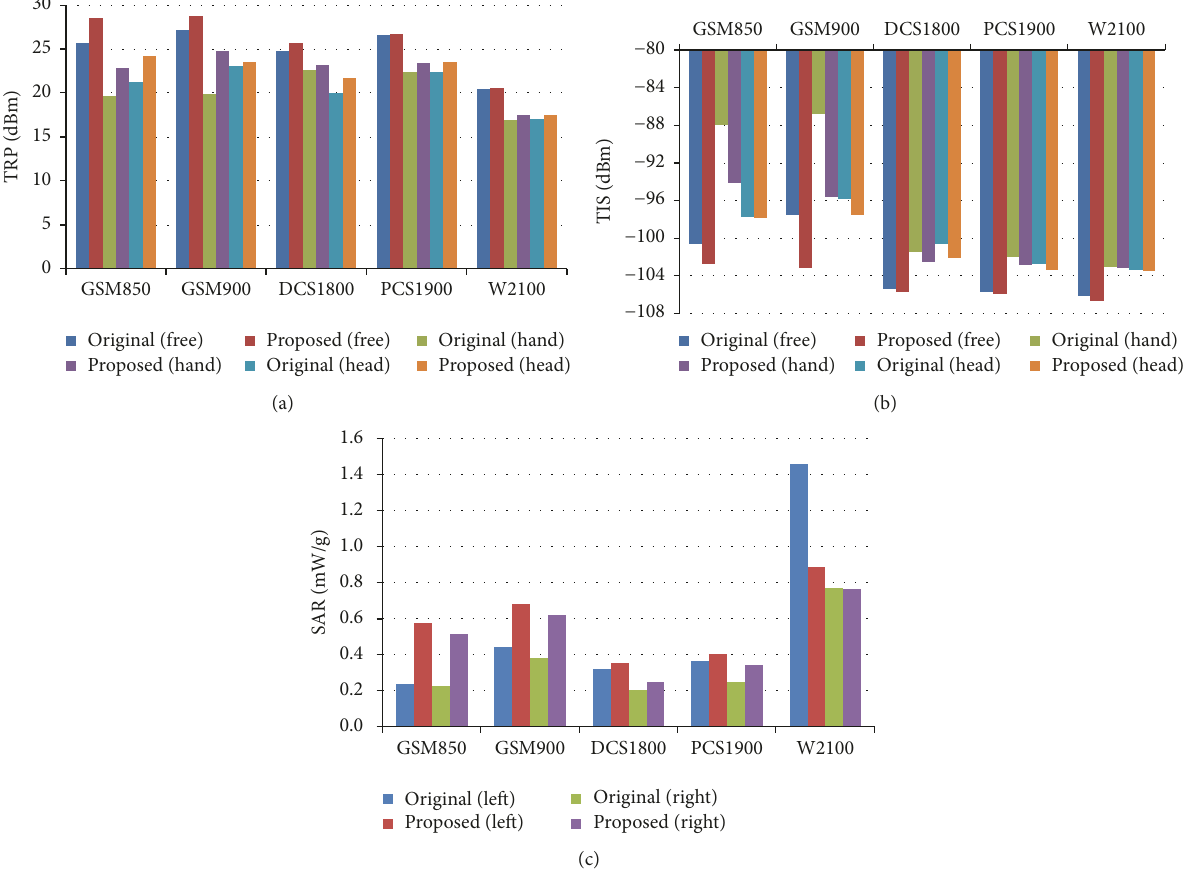
Figure 10: Comparison of the measured active performances of the proposed antenna and the original antenna of the device. (a) TRP. (b) TIS. (c) SAR